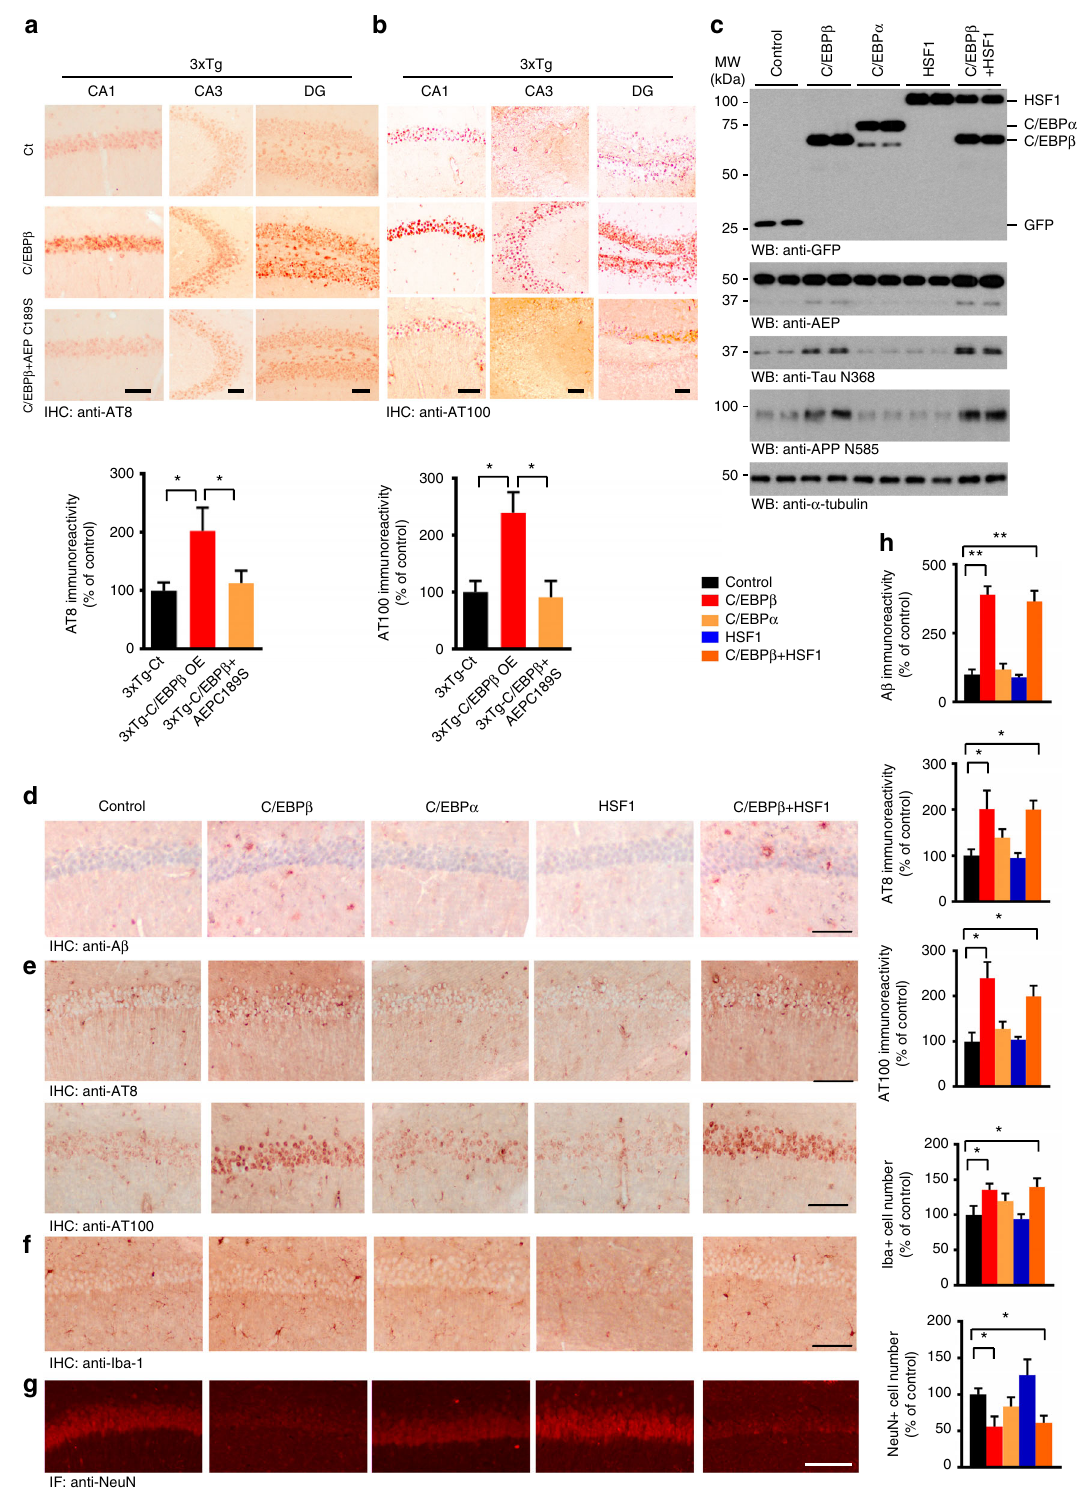
Fig. 6 Speci fi city of C/EBP β overexpression in accelerating AD-like pathogenesis. a , b AT8 and AT100 IHC staining of Tau pathology in different hippocampal regions. Overexpression of C/EBP β signi fi cantly escalated Tau hyperphosphorylation in 3xTg mice. Data represent mean ± s.e.m. of 12 – 18 sections from three mice in each group (* P < 0.05, one-way ANOVA). Scale bar, 100 μ m. c Overexpression of C/EBP α or HSF1 does not escalate delta-secretase and APP and Tau cleavage by delta-secretase. Hippocampal tissues from both control and virus injected 3xTg mice were analyzed by immunoblotting. C/EBP β -induced active delta-secretase was not antagonized by the co-expression of HSF1, an unrelated transcription factor ( n = 4 mice per group). d – g Immunostaining of A β , AT8, AT100, Iba-1, and NeuN in hippocampal CA1. h Quanti fi cations of A β , AT8, AT100, Iba-1, and NeuN immuno- reactivities represent mean ± s.e.m. of 12 – 18 sections from three mice in each group (* P < 0.05, one-way ANOVA). Scale bar, 150 μ